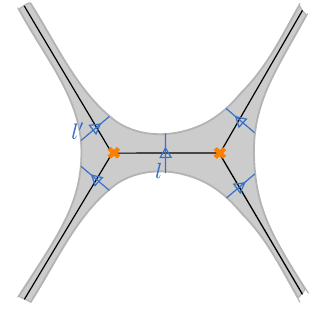
Figure 71 . A region C (cid:14) of C bounded by generic leaves of the WKB foliation, and the critical leaves contained therein, before (left) and after (right) crossing a hypermultiplet K -wall. The charge (cid:13) of the hypermultiplet is also shown.